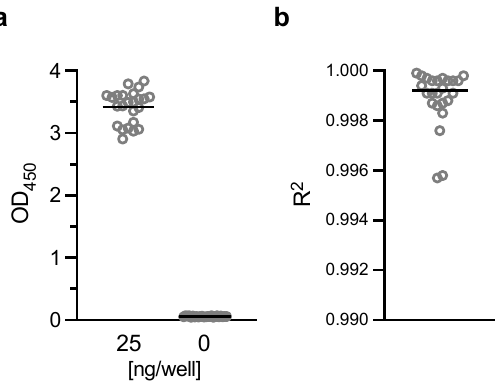
Figure 6. Quality control for standard. ( a ) AIA was performed as described in Figure 3. OD 450 values at the highest (25 ng/well) or the lowest (0 ng/well, blank) concentrations ( a ), and R 2 of 4-parameter sigmoid fits ( b ) of standards from the 24 independent assays are shown (dots). The bars represent mean in ( a ) and median in ( b ).